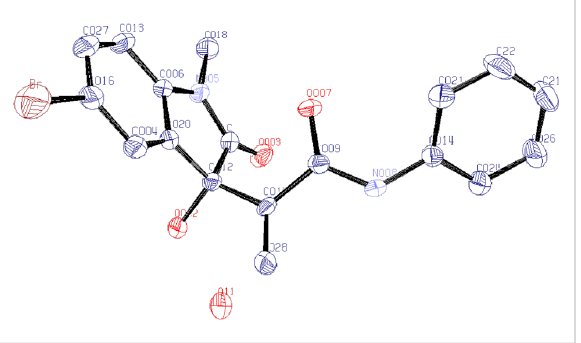
Figure 2: ORTEP diagram of 3ea (ellipsoids are drawn at 50% proba- bility).